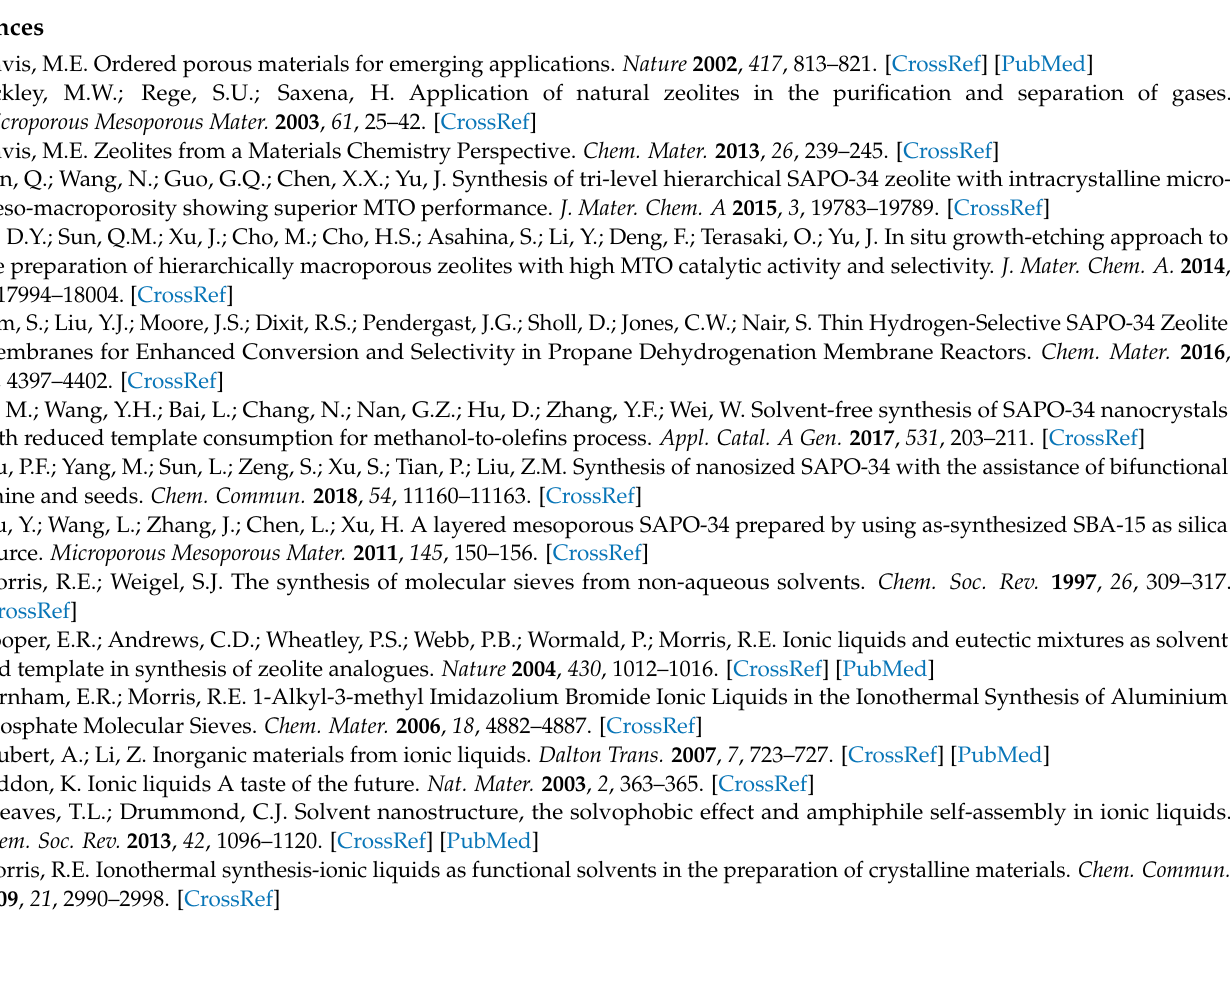
samples under different molar amounts of HF. Figure S4: SEM images of samples under different molar amounts of HF. Figure S5: ( a ) N 2 adsorption-desorption isotherms and ( b ) BJH pore size distributions of triclinic SAPO-34 molecular sieves. Figure S6: XRD patterns of samples at different crystallization times. Figure S7: SEM images of samples at different crystallization times. Figure S8: Structure of ionic liquids. Figure S9: SEM images of samples under different molar amounts of TEA. Figure S10: SEM images of samples at different molar amounts of TEA. Figure S11: Structure of different templating agents. Figure S12: XRD patterns of samples under different types of template. Figure S13: SEM images of samples under different types of template. Figure S14: NH3-TPD patterns of SAPO-34 molecular sieves. Table S1: XRD date of different samples. Table S2: Structural parameters of SAPO-34 molecular sieves. Table S3: Synthesis conditions in [EMIm]Cl. Table S4: Synthesis conditions in different ionic liquids. Table S5: Synthesis conditions in different